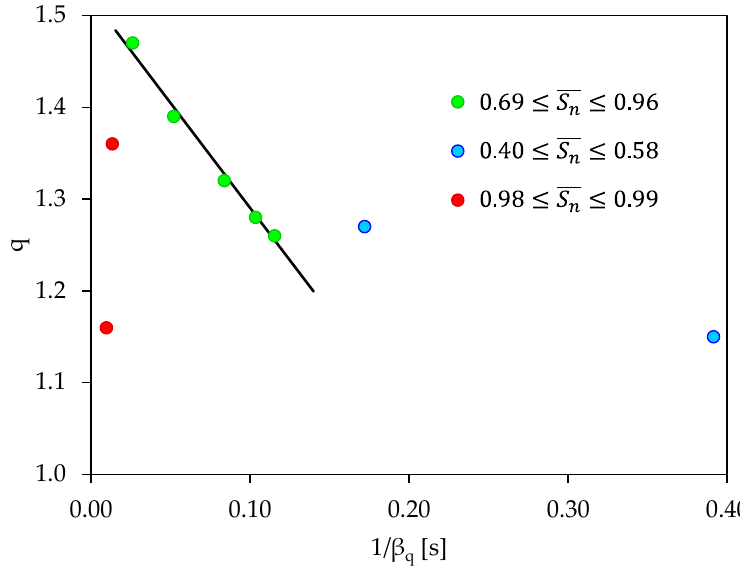
β for the UC protocol. q